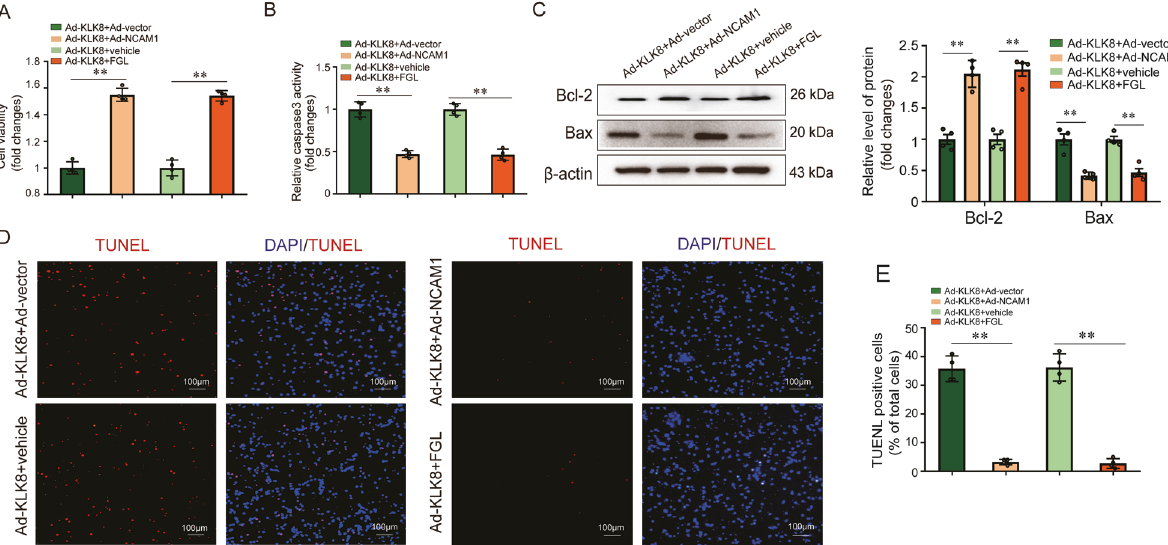
Fig. 8 Both NCAM1 overexpression and NCAM1 mimetic peptide FGL rescue KLK8-overexpressed primary hippocampal neurons from apoptosis. Primary hippocampal neurons were infected with KLK8 adenovirus (Ad-KLK8) at a multiplicity of infection (MOI) of 3 with or without NCAM1 adenovirus (Ad-NCAM1, MOI 3) or NCAM1 mimetic peptide FGL (1 μ g/ml) for 24 h. A , B CCK8 assay and measurement of caspase-3 activity showed that both Ad-NCAM1 and FGL blocked Ad-KLK8-induced cell injury and caspase-3 activation in primary hippocampal neurons, respectively. C Protein levels of Bcl-2 and Bax were determined by western blot analysis. The representative protein bands (left) and the corresponding histograms (right) showed that both Ad-NCAM1 and FGL peptide reversed Ad-KLK8-induced changes in protein levels of Bcl-2 and Bax. D Showed representative TUNEL-stained (red) cells. Nuclei were counterstained with DAPI (blue). Scale bar = 100 μ m. E The TUNEL-positive cell number (%) was shown as a ratio of the number of TUNEL-positive cells to the total cell number. D , E Showed that both Ad-NCAM1 and FGL peptide reversed Ad-KLK8-induced primary hippocampal neuron apoptosis. Data were presented as means ± SD ( n = 4, one-way ANOVA, Bonferroni ’ s post hoc test). ** p <